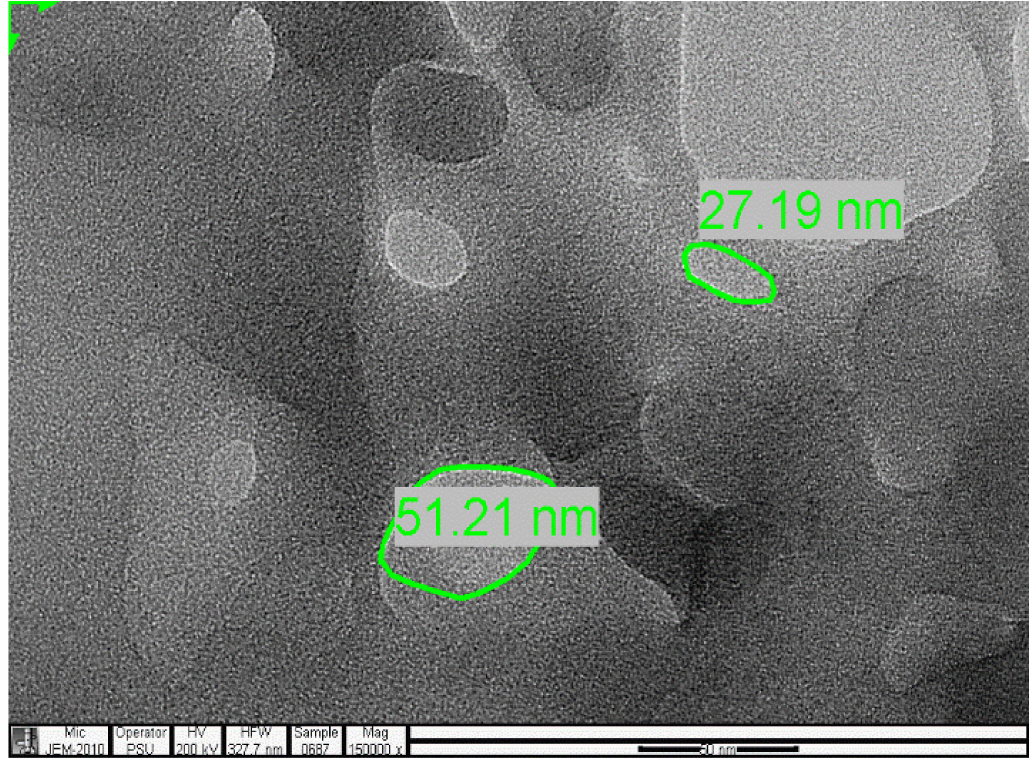
Figure 16. TEM micrograph of the Nicotine 3-Phenylpiridine